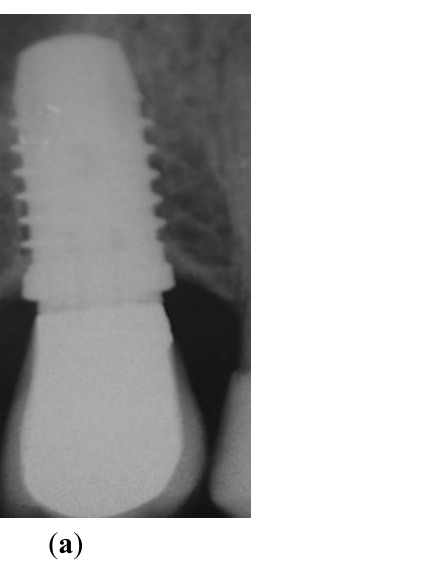
Figure 5. Peri-apical X-rays taken after AC. ( a ) Position 15; ( b ) Position 25. No pathological signs were visible around both implants.